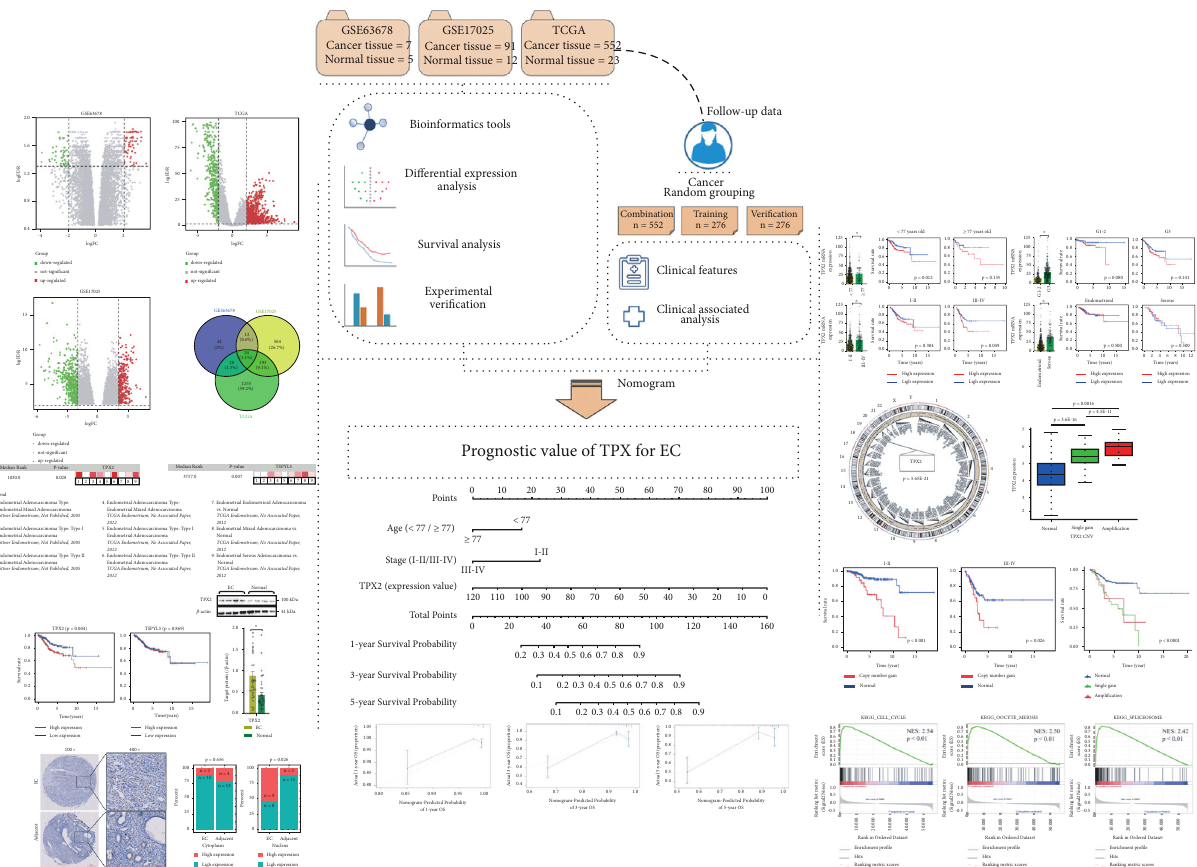
Figure 1: Flow diagram depicting the flow of work in this study. EC: endometrial cancer; CNV: copy number variation; GSEA: gene set enrichment analysis; DEG: differentially expressed